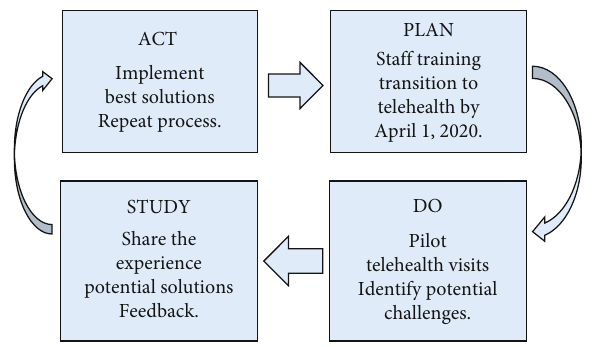
Figure 1: Plan Do Study Act model to train clinical faculty physicians and